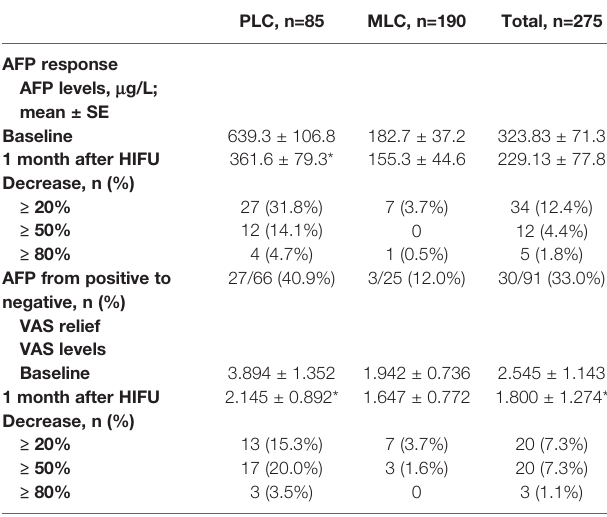
FIGURE 3 | DOR and OS by different liver cancer types. (A) DOR strati fi ed analysis by PLC and MLC according to the mRECIST criteria. The log-rank test indicates that patients with PLC prolong the DOR compared with cases with MLC ( p = 0.001). (B) DOR strati fi ed analysis by PLC and MLC according to the RECIST 1.1 criteria. The log-rank test indicates no difference between these two groups ( p = 0.070) (C) OS with 95% CI of the overall cohort including PLC and MLC. (D) OS strati fi ed analysis by PLC and MLC. The log-rank test indicates that patients with PLC would improve the survival outcome compared with cases with MLC ( p = 0.000). TABLE 3 | Alpha-fetoprotein (AFP) and visual analog scale (VAS)